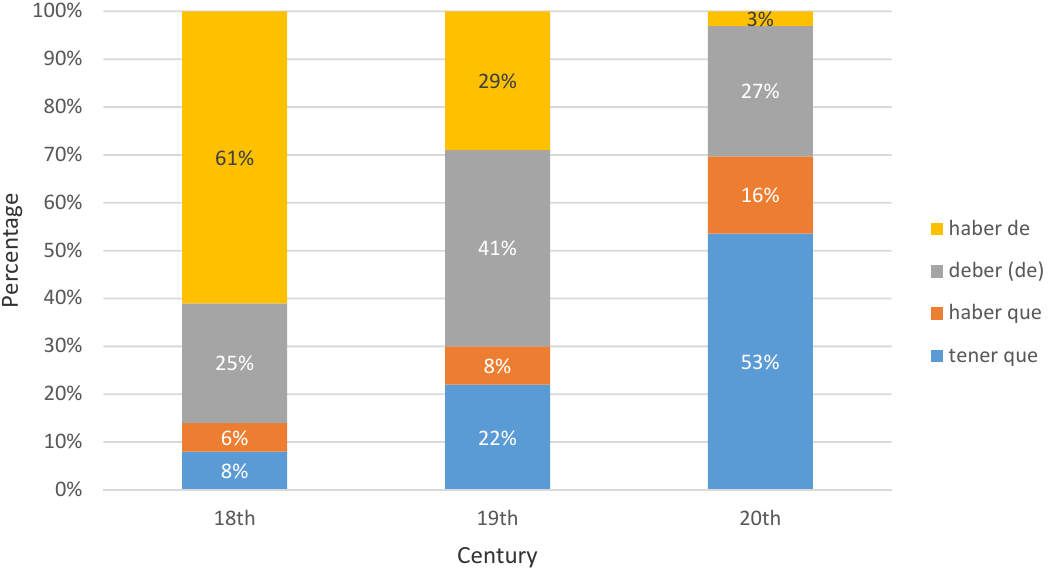
Figure 3. Increase in frequency of tener que among modal constructions from the 18th to the 20th century (adapted from (Bauman 2013, p. 147)).